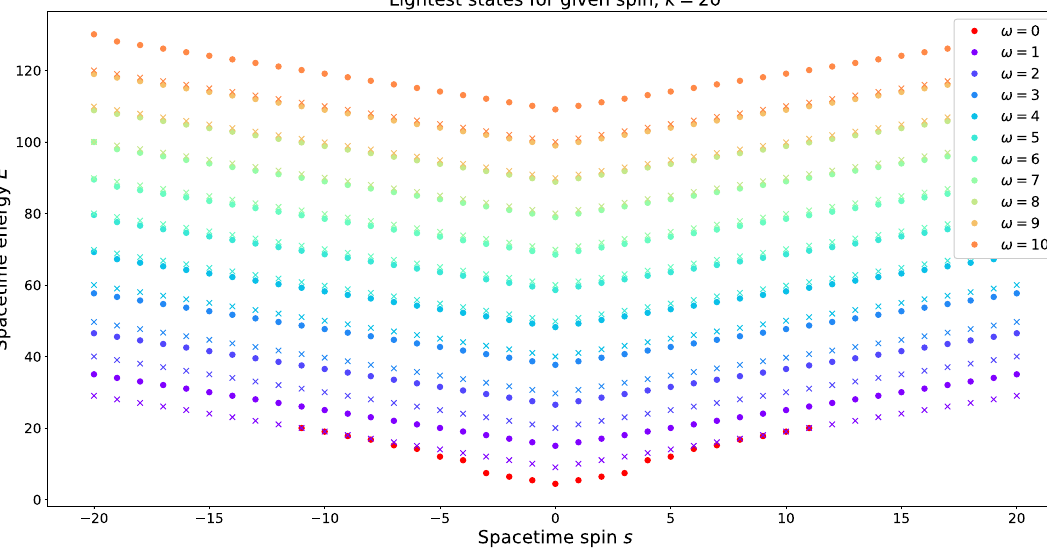
Figure 1 . Lowest energy states for (cid:12)xed k = 20 as a function of the spin s . Crosses denote continuous representations (long strings), whereas dots correspond to discrete representations. The red dots describe the un(cid:13)owed discrete states, while the di(cid:11)erent bands correspond, in turn, to the (cid:13)ows ! = 1 ; 2 ; : : : ; 10. The lines corresponding to the spectrally (cid:13)owed representations have been arti(cid:12)cially capped for illustration purposes; they continue all the way to s = (cid:6)1